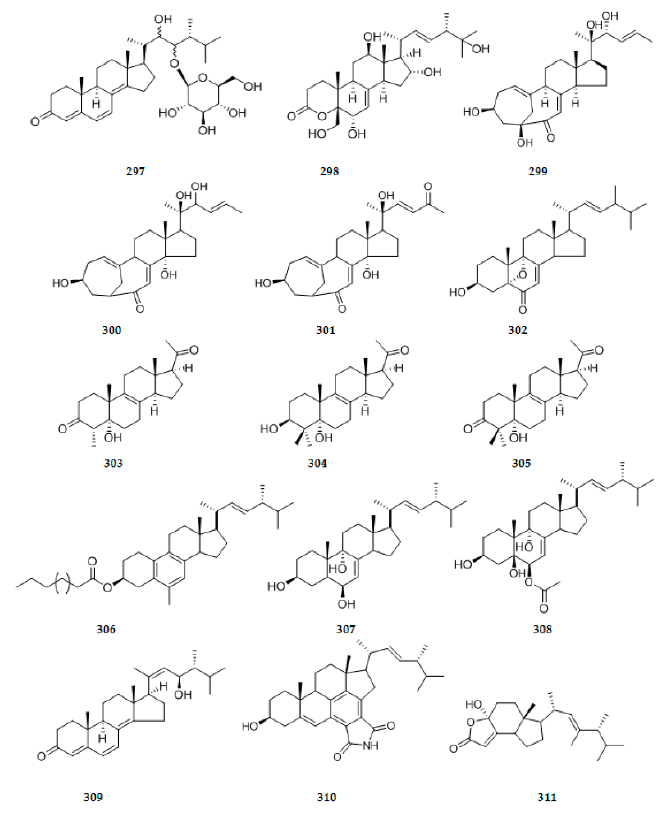
Figure 11. Chemical structures of sterides.